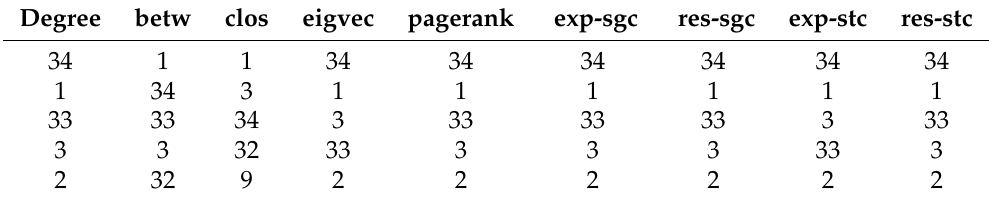
Table 3. Ranking of the five most important nodes for the karate network identified by the centrality function of Matlab, the f -subgraph centrality, and f -starting